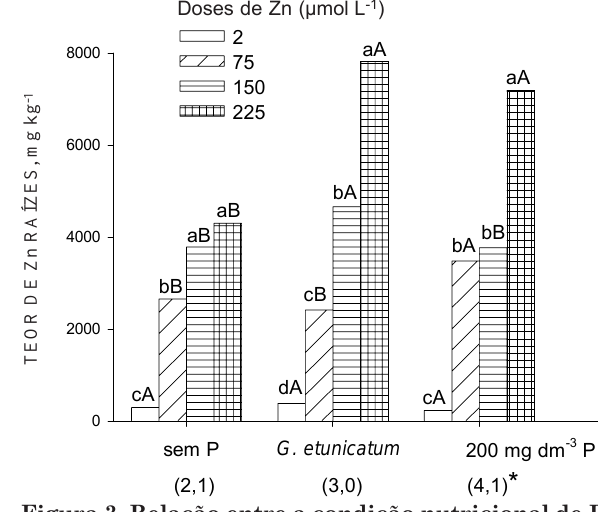
Figura 2. Colonização micorrízica e matéria seca relativa ( % do controle com 2 μ mol L -1 de Zn ) de mudas de Trema micrantha pré- colonizadas com G. etunicatum após 40 dias de crescimento em solução nutritiva que continha doses crescentes de Zn. Barras verticais representam o erro-padrão da média de três repetições.